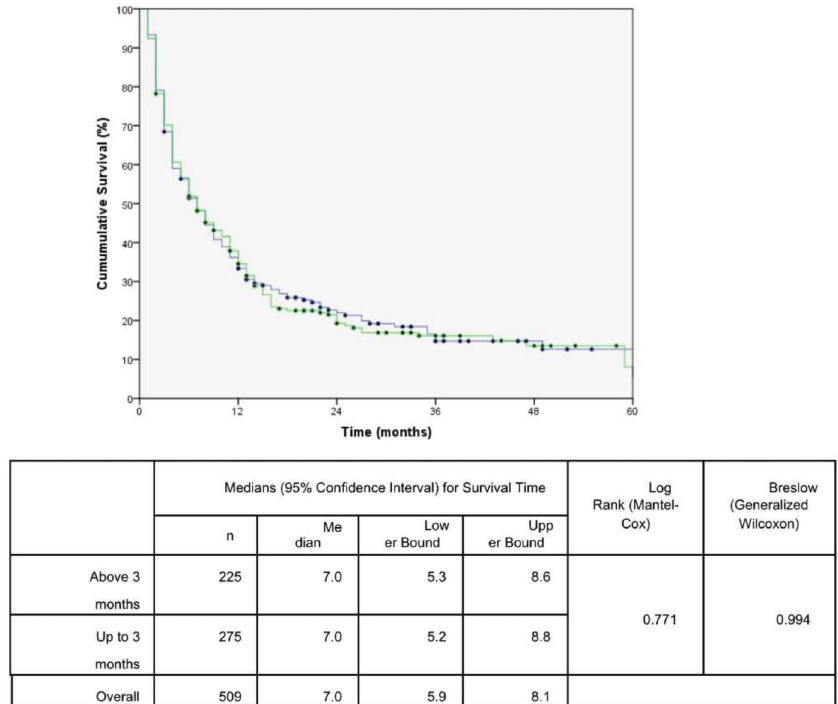
Figure 1 - Kaplan Meier curve for mortality due to lung cancer in patients according to time from the patient history (PH) to diagnosis (DX). The blue line represents the patients diagnosed up to 3 months, and the green line represents patients diagnosed above 3 months.